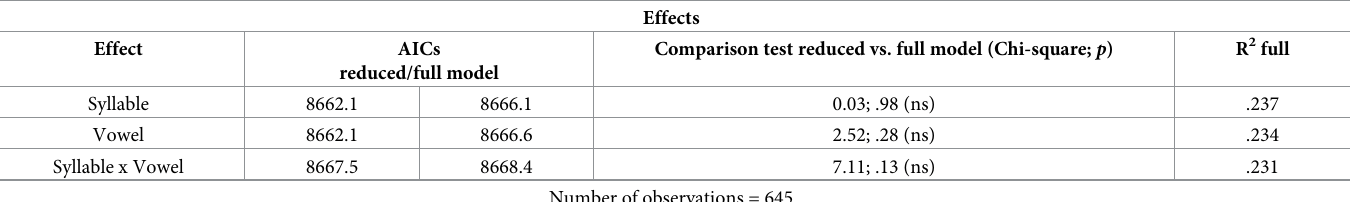
Table 5. Effects on F 2 (in Hz) at the midpoint of the steady state.